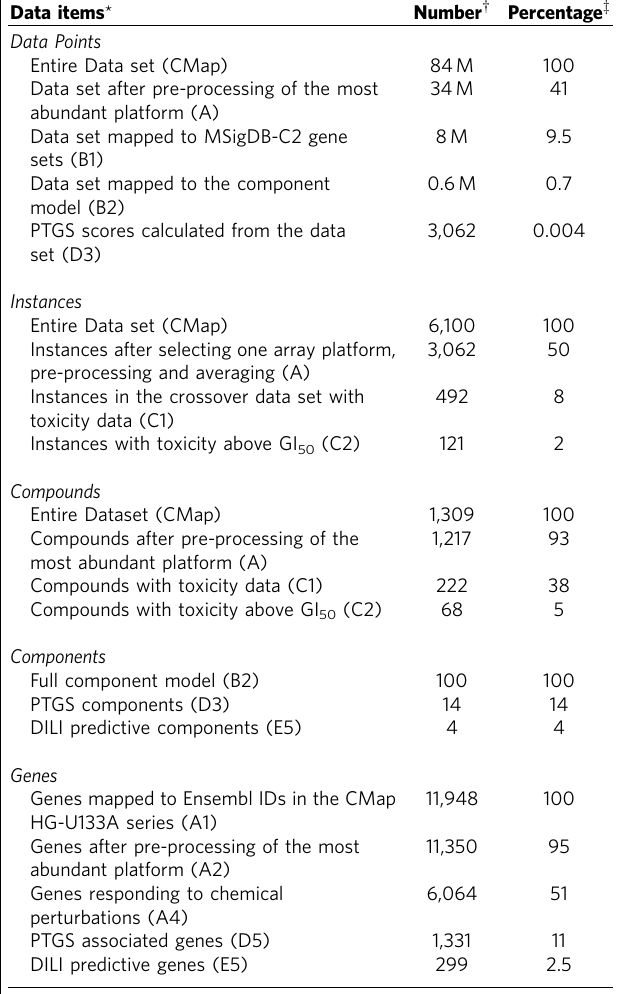
Table 1 | Key features of data processing that generated the Predictive Toxicogenomics Space